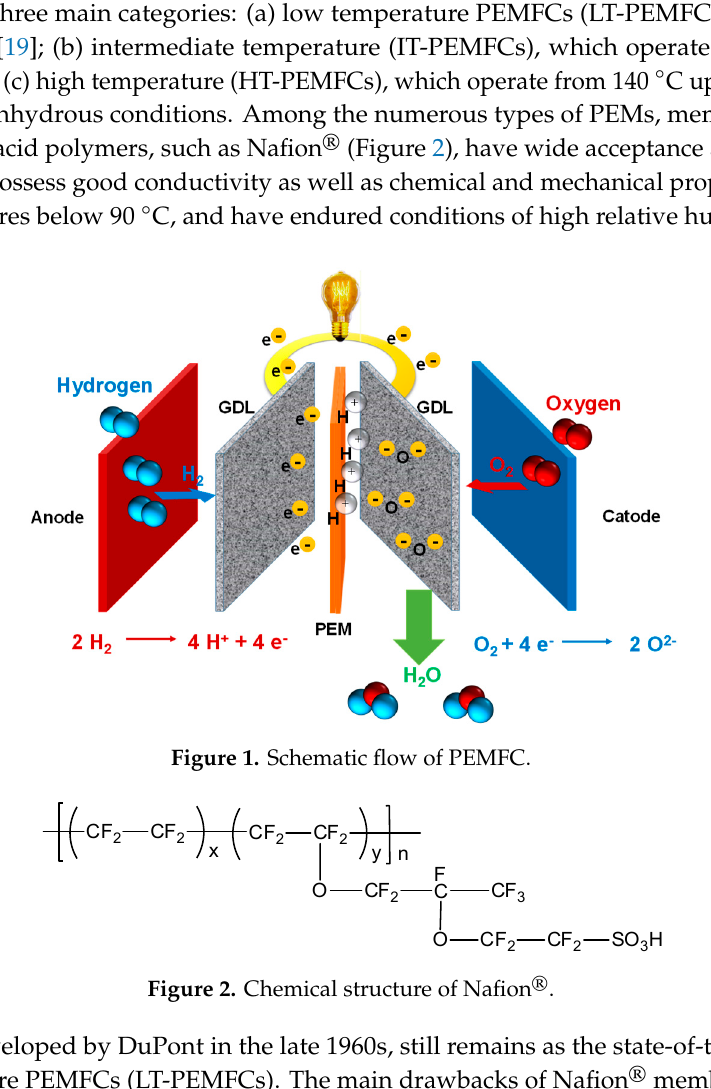
Figure 2. Chemical structure of Nafion ® .